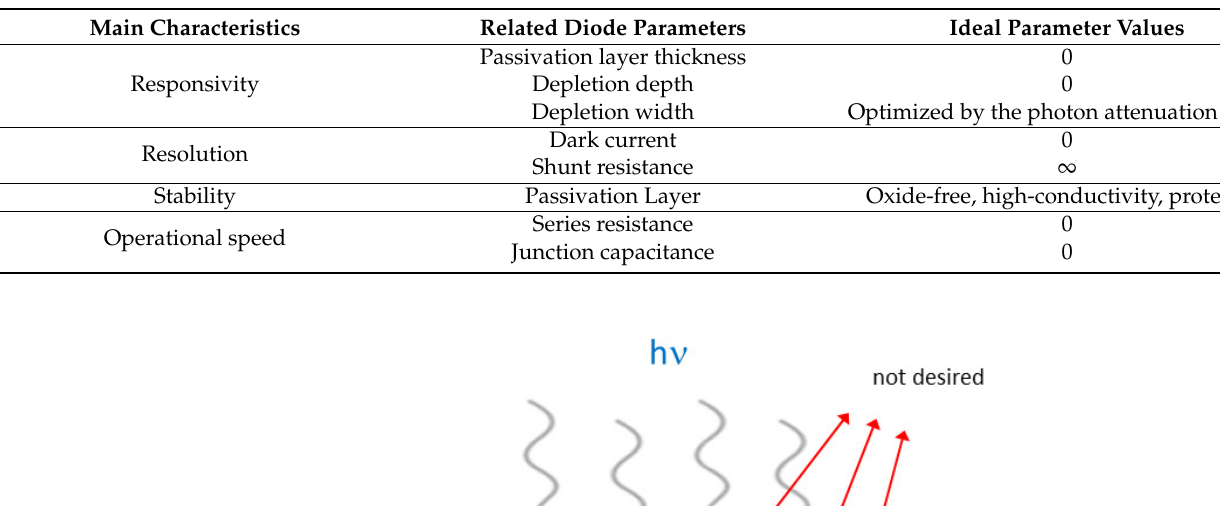
Table 1. Main characteristics and related parameters of an ideal silicon-based photodetector.